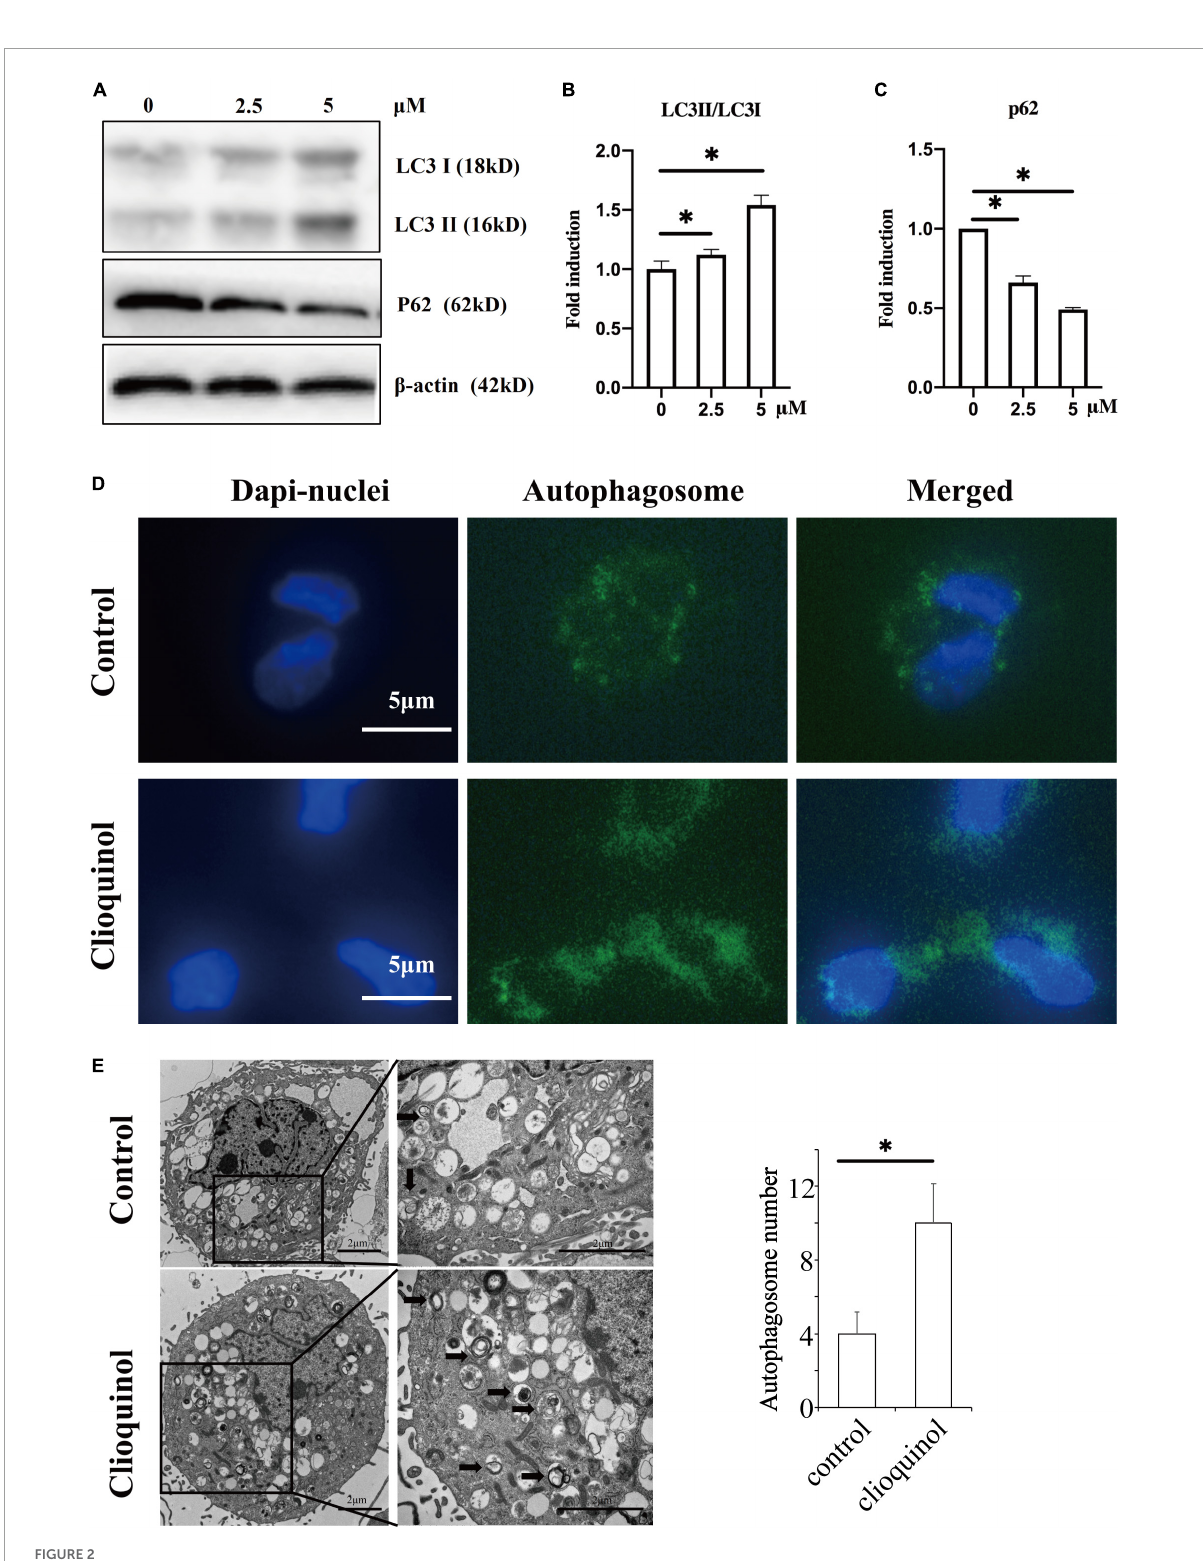
FIGURE2 Clioquinol induces autophagy in human osteoarthritis (OA) chondrocytes. The expression of LC3, p62, and β -actin were detected with Western blotting (A–C) . Human OA chondrocytes were treated or not treated with 5 µ M of clioquinol for 48 h, and autophagosome formation (green dots) was detected using an autophagy detection kit (D) and transmission electron microscopy (E) . All data are shown as the mean ± SD. ∗ p <